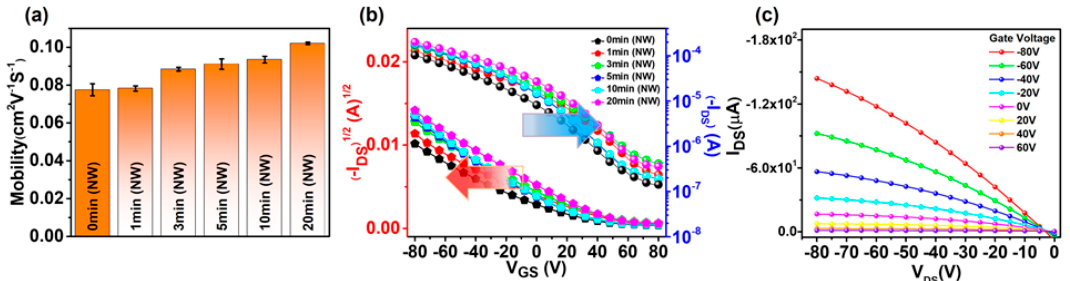
Figure 7. ( a ) Average field-effect mobilities of P3HT-NW film-based organic field-effect transistors (OFETs) as a function of CF vapor annealing time. ( b ) Transfer curves of the corresponding OFETs. ( c ) Output curve of OFETs based on P3HT-NW film annealed with CF vapor for 20 min.